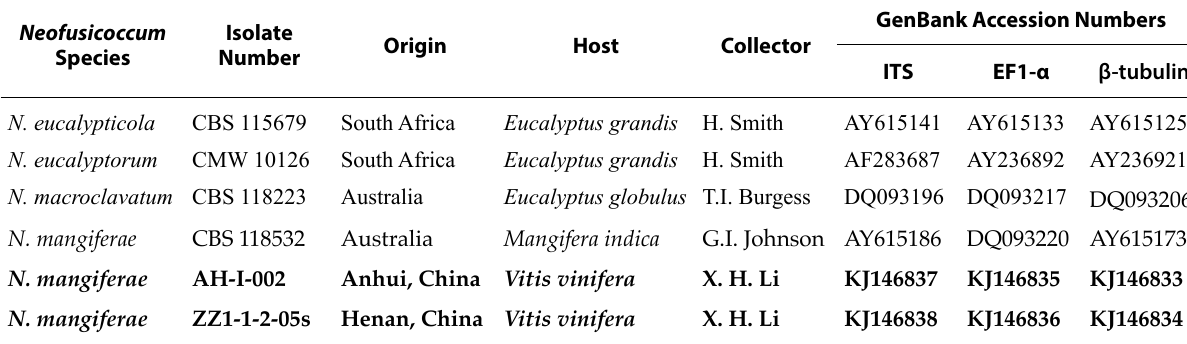
Table 1. Isolates used in this study. Neofusicoccum mangiferae isolates obtained in this study are in bold. Neofusicoccum